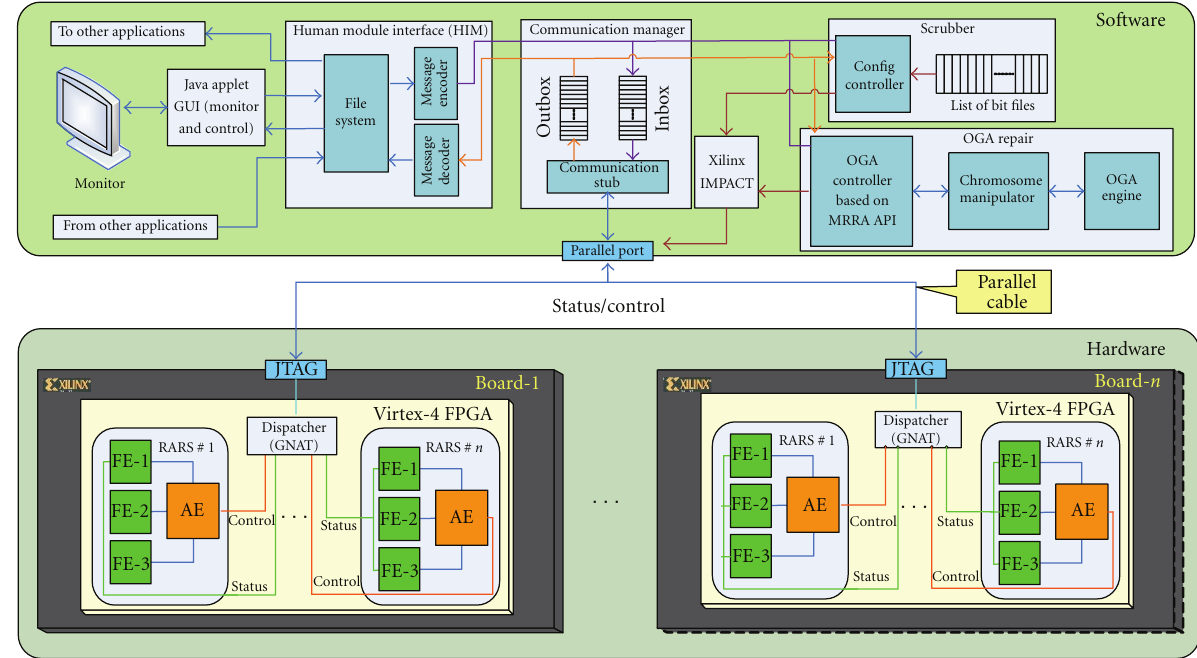
Figure 2: SMART prototype top-level hardware and software